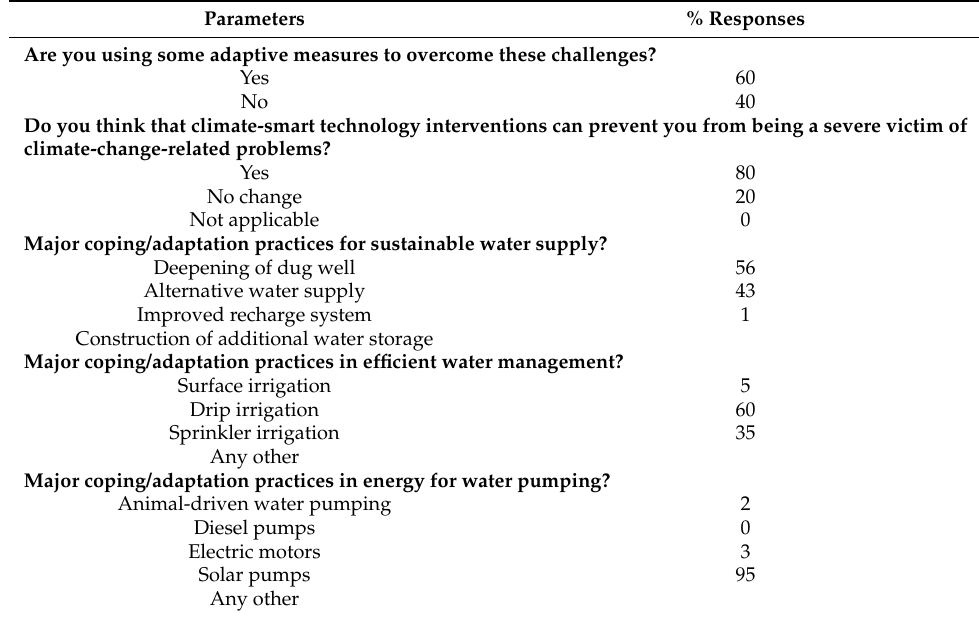
Table 11. Adaptive strategies by the